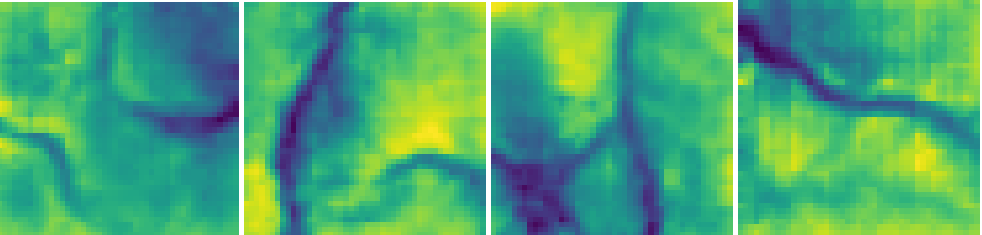
Figure 2. From the left: The first two images are real data from the OpenTopology website. The last two pictures are generated 2D images with